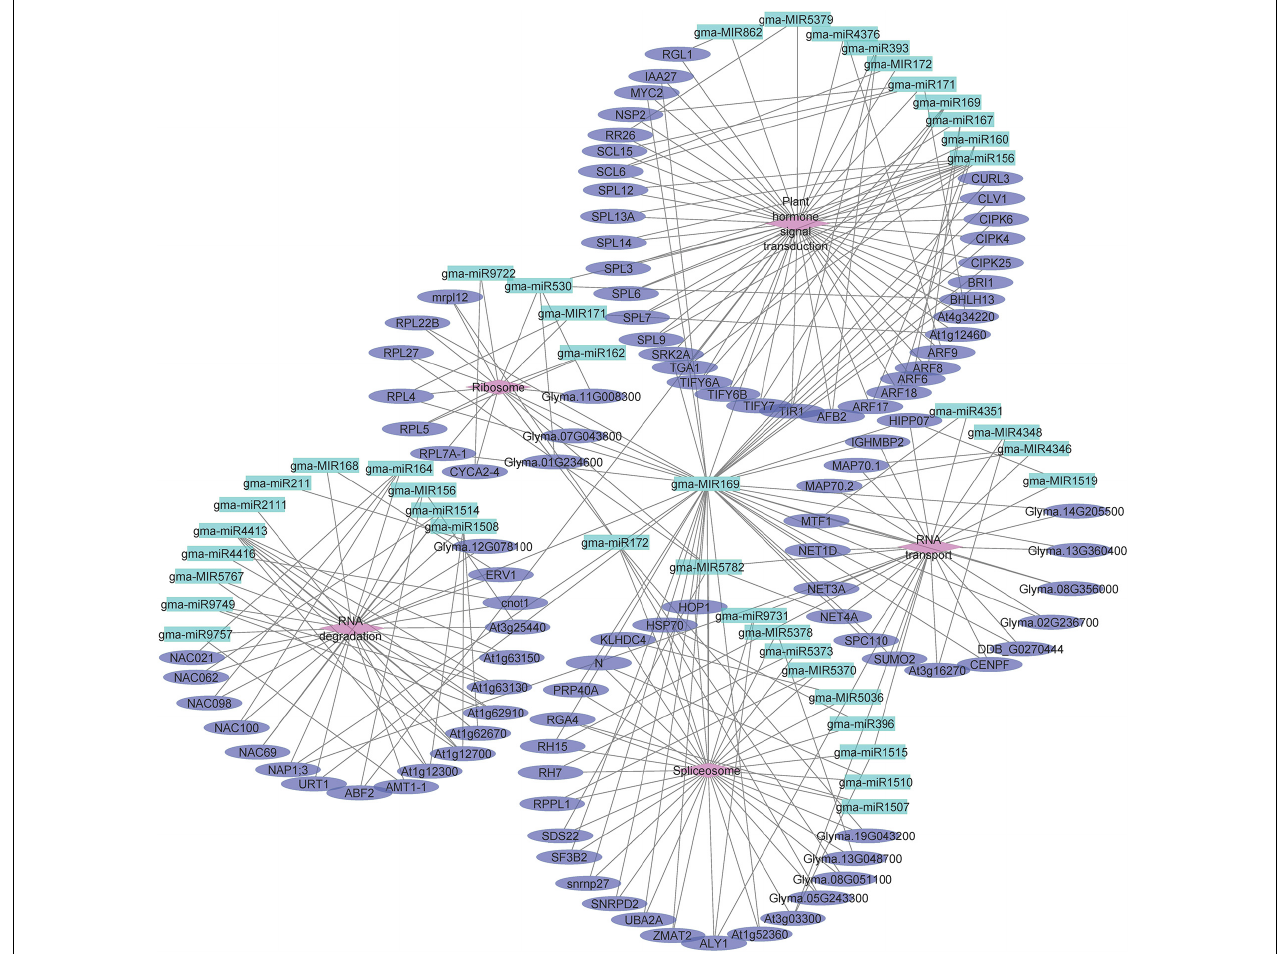
FIGURE 6 | The regulatory network comprising KEGG pathways, microRNAs (miRNAs), and target genes in JLCMS9A and JLCMS9B. Diamonds, ellipses, and arrowheads represent the KEGG pathways, target genes, and miRNAs,